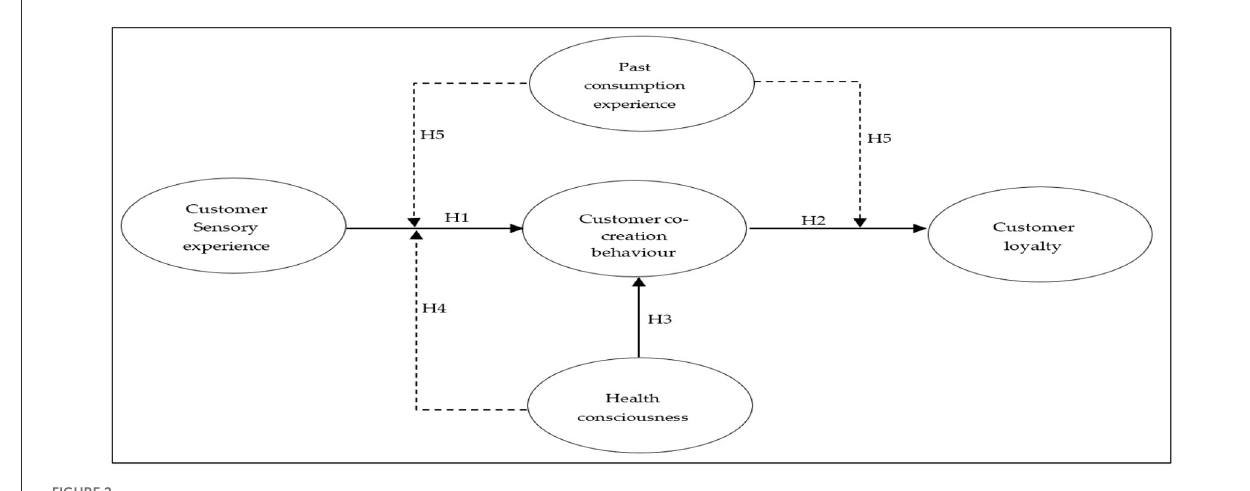
FIGURE2 The conceptual framework.